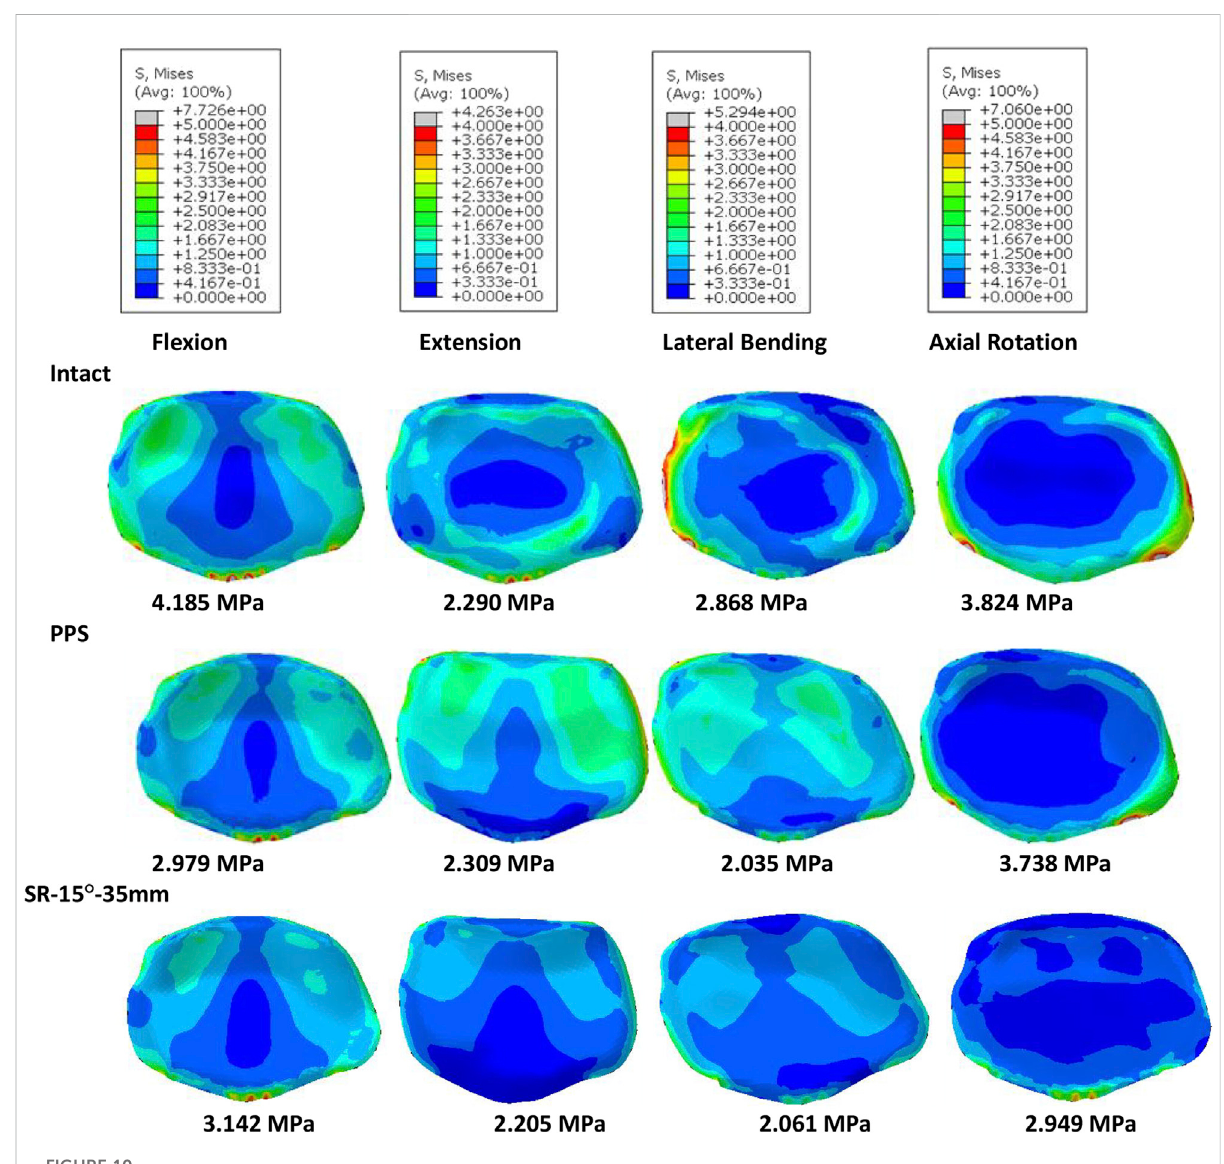
FIGURE 10 Von-Mises stress on the L4 endplate of the intact model, PPS model, and SR model, with the mean stress noted beneath each